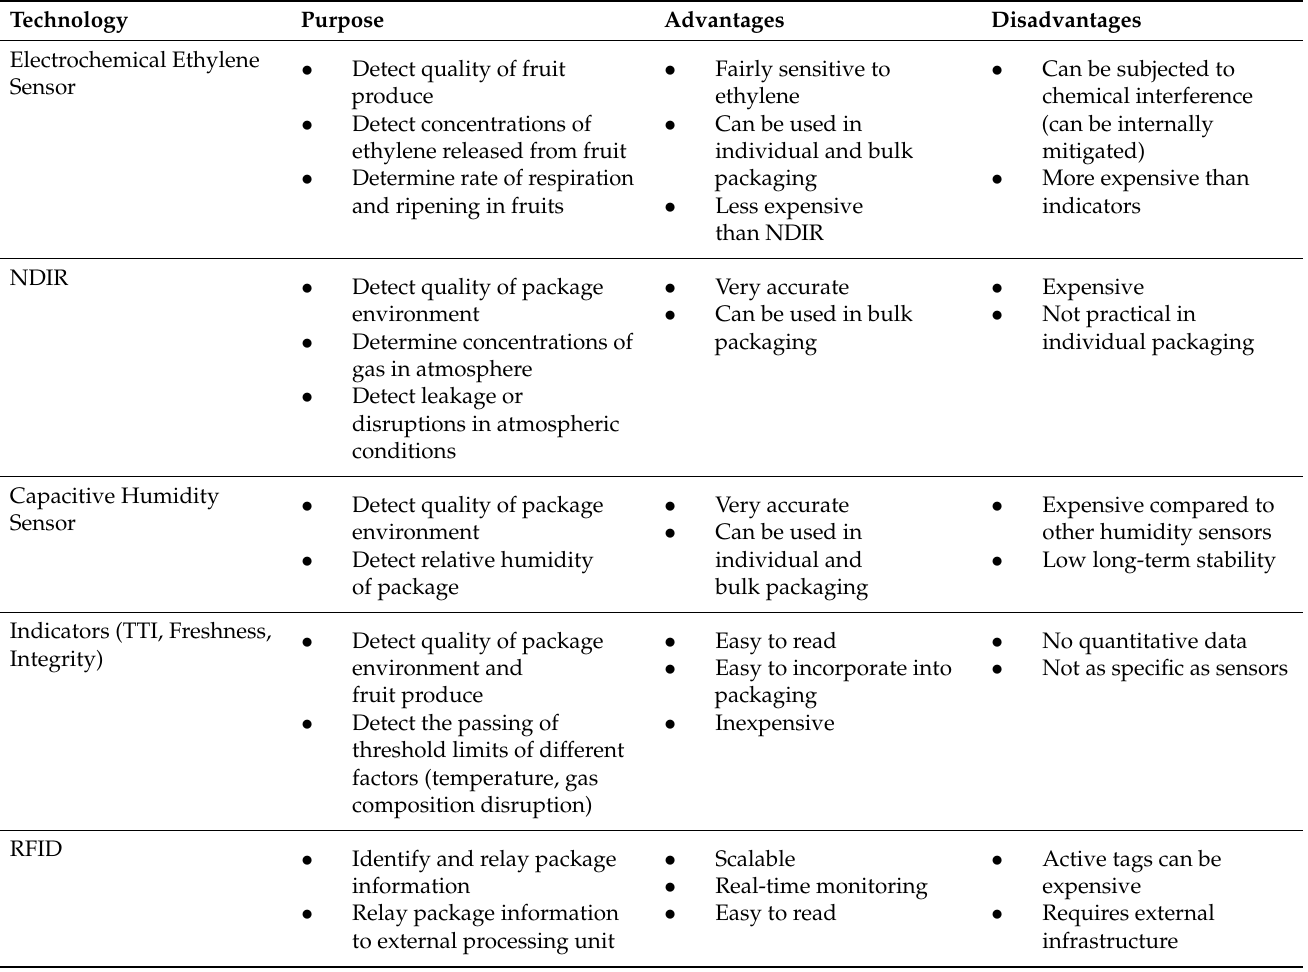
Table 4. Comparison summary of intelligent systems in fruit packaging